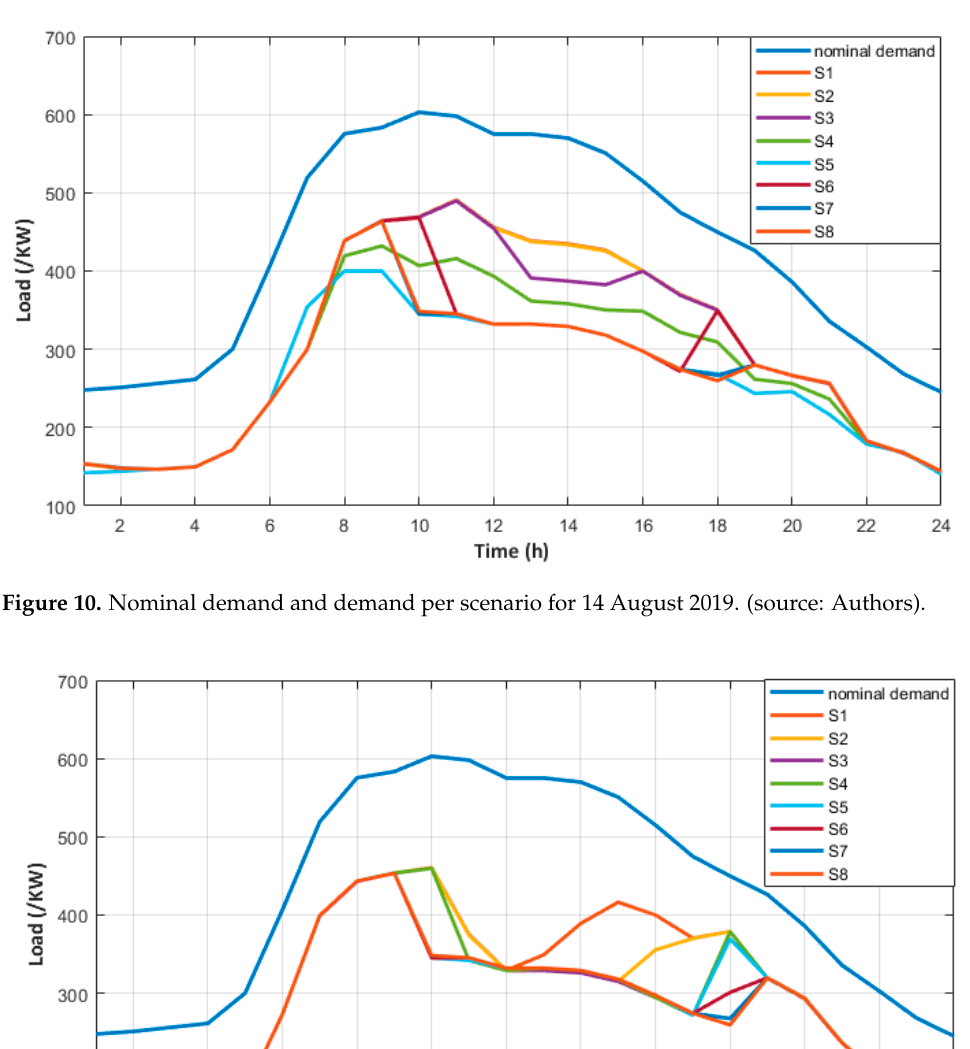
Figure 12. Nominal price and RTPs per elasticity values. (source: Authors).